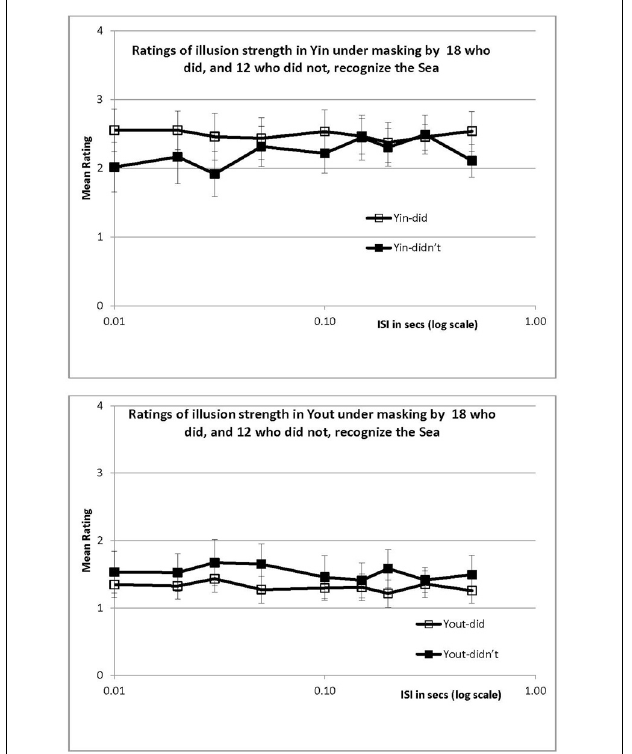
FIGURE 6 | Mean ratings in Experiment 4 (masking) of Yin (upper panel) and Yout (lower panel), for recognizers and non-recognizers, plotted against ISI in log s. Ratings were relative, as in Experiment 3. Error bars show ± 1 standard error of each